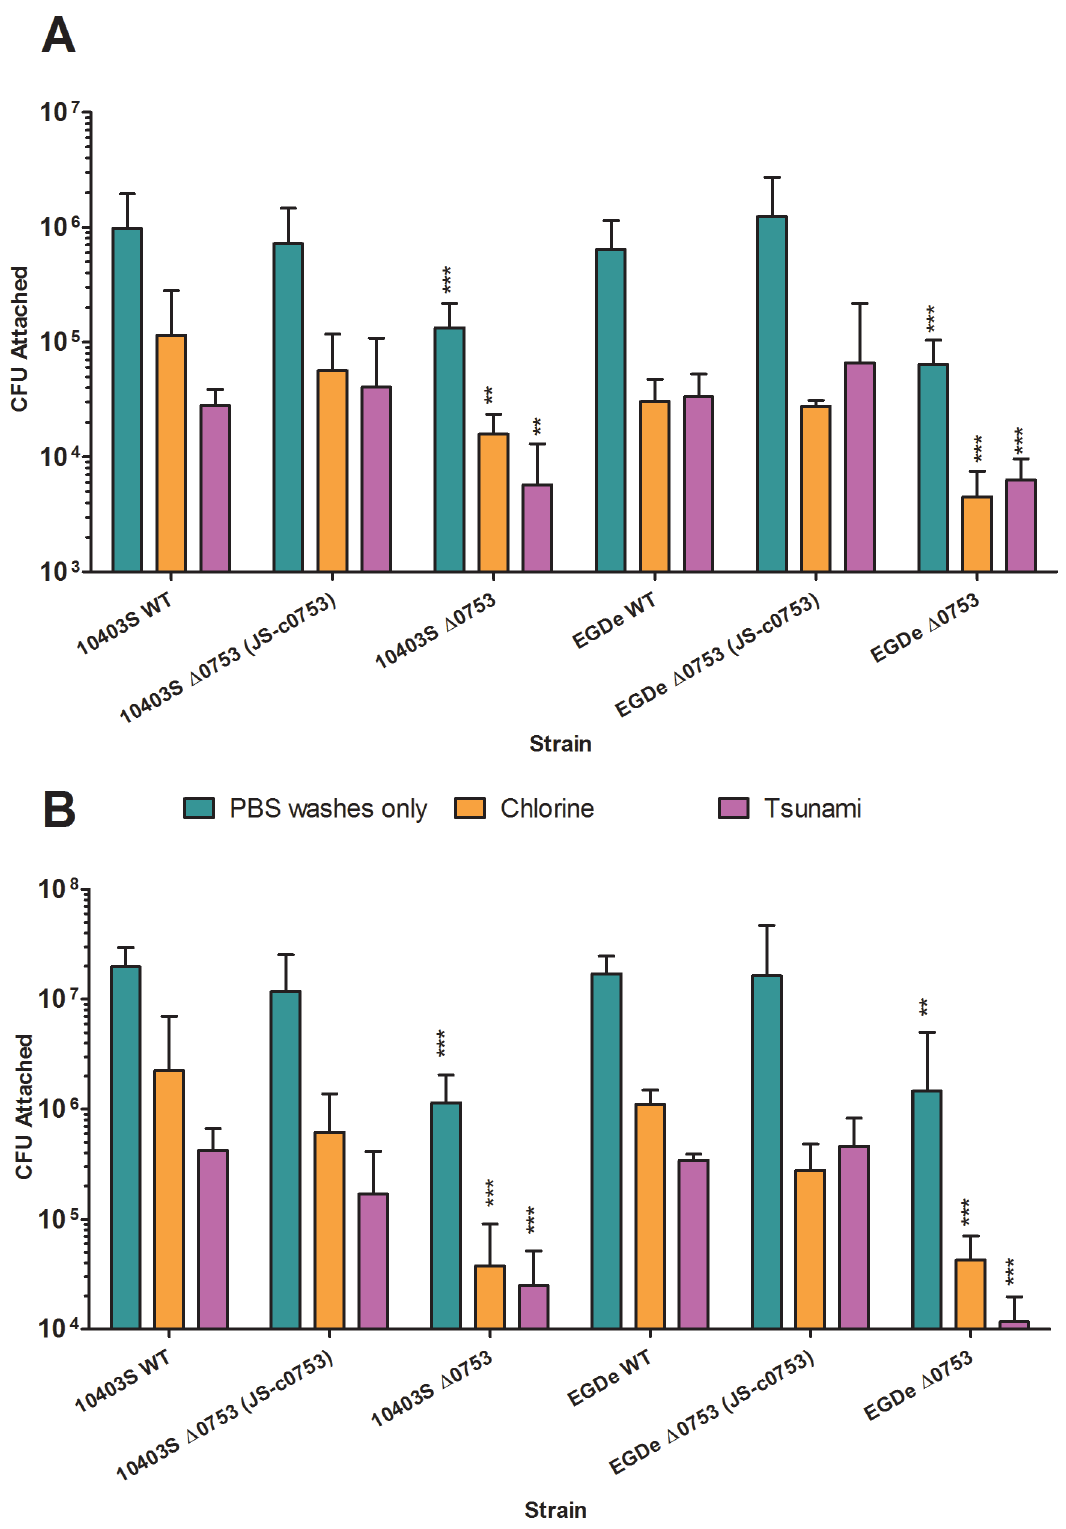
Figure 3. L.monocytogenes attachment to fresh produce surface. A) Bacterial attachment to romaine lettuce. B) Bacterial attachment to cantaloupe rind. Standard deviations represent three independent experiments. Significant differences in comparison to the parent strains under the same condition are shown as * ( P , 0.5), ** ( P , 0.001), and *** ( P , 0.0001).